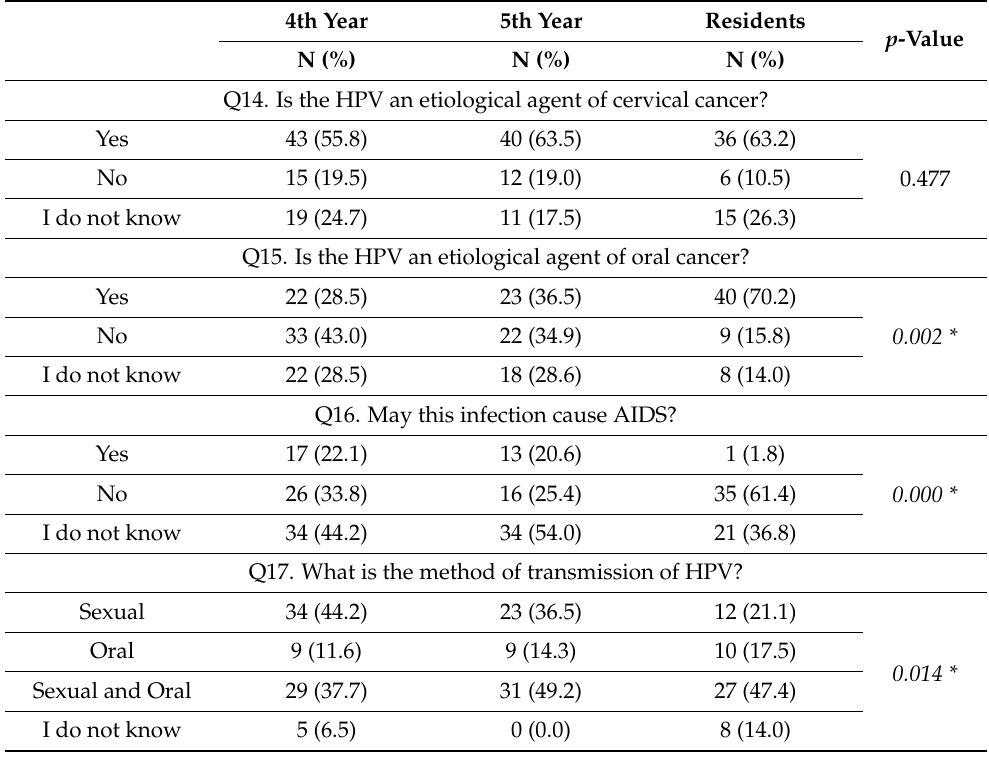
Table 3. Assessment of HPV knowledge among study